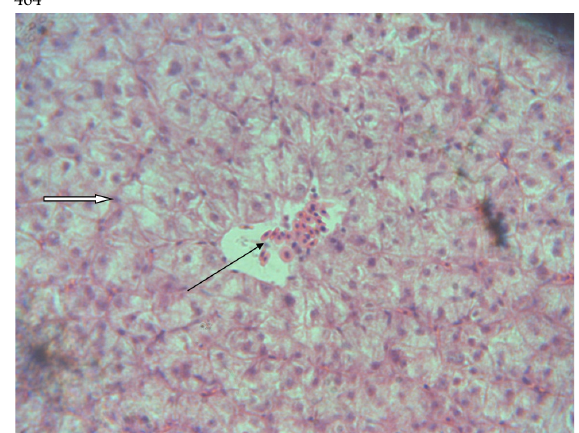
Fig. 5. Group E H&E X400 LIVER. Normal liver showing central vein with red blood cells inside (small black arrow), hepatocytes (white